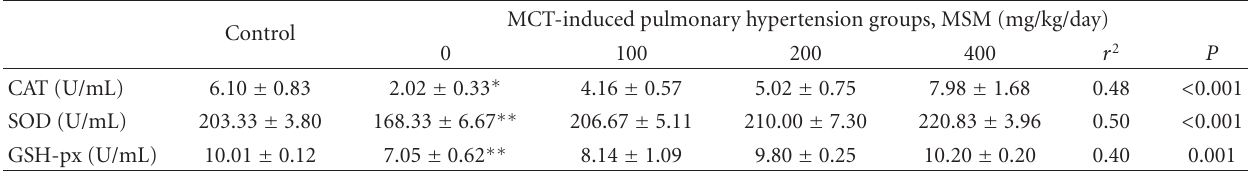
Table 2: E ff ects of di ff erent doses of methylsulfonylmethane (MSM) on the activities of antioxidant enzymes in rats with monocrotaline- (MCT-) induced pulmonary